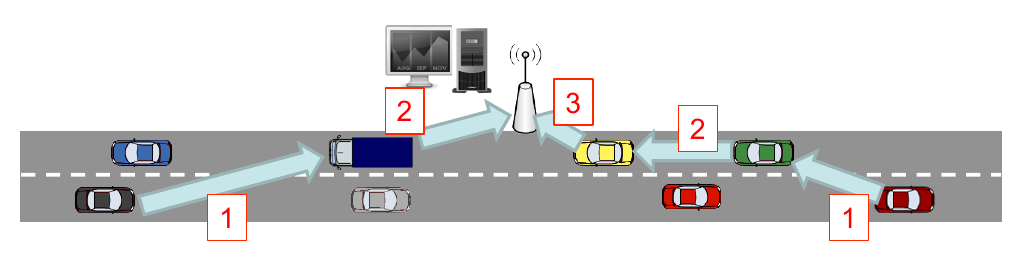
Figure 4. Query broadcast stage 2.